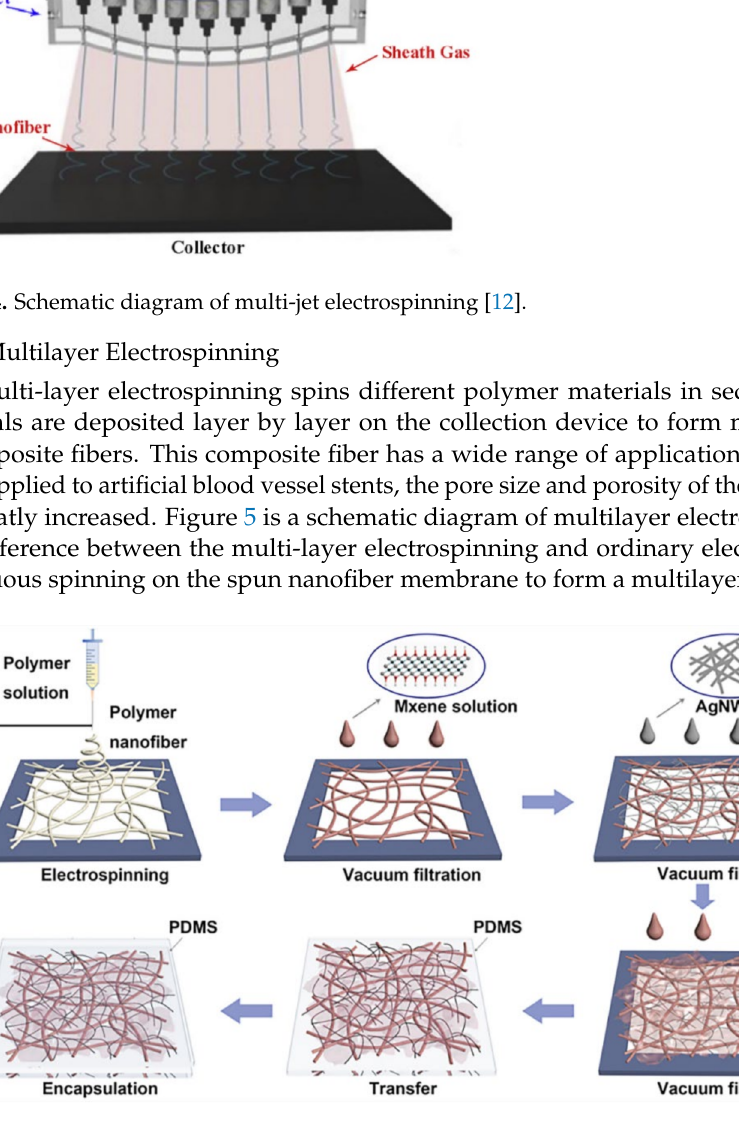
Figure 5. Schematic diagram of multilayer electrospinning